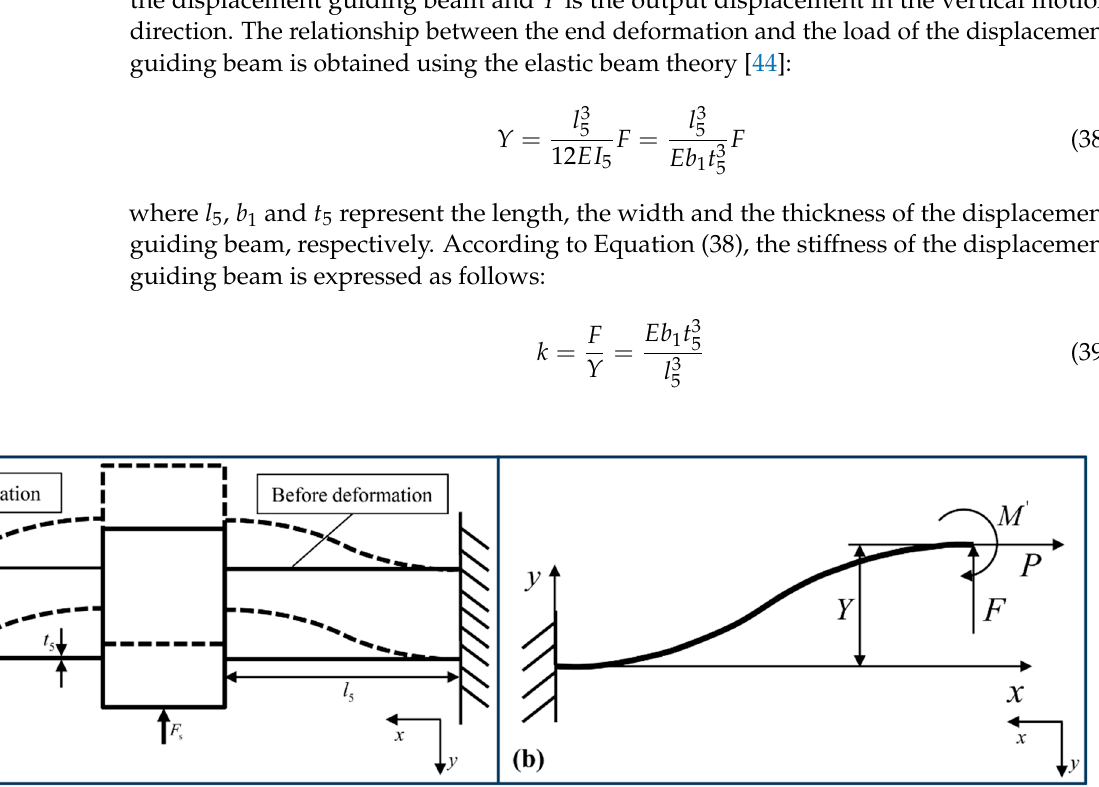
Figure 12. ( a ) Deformation schematic of the displacement guiding mechanism. ( b ) Mechanical model of the displacement guiding beam.